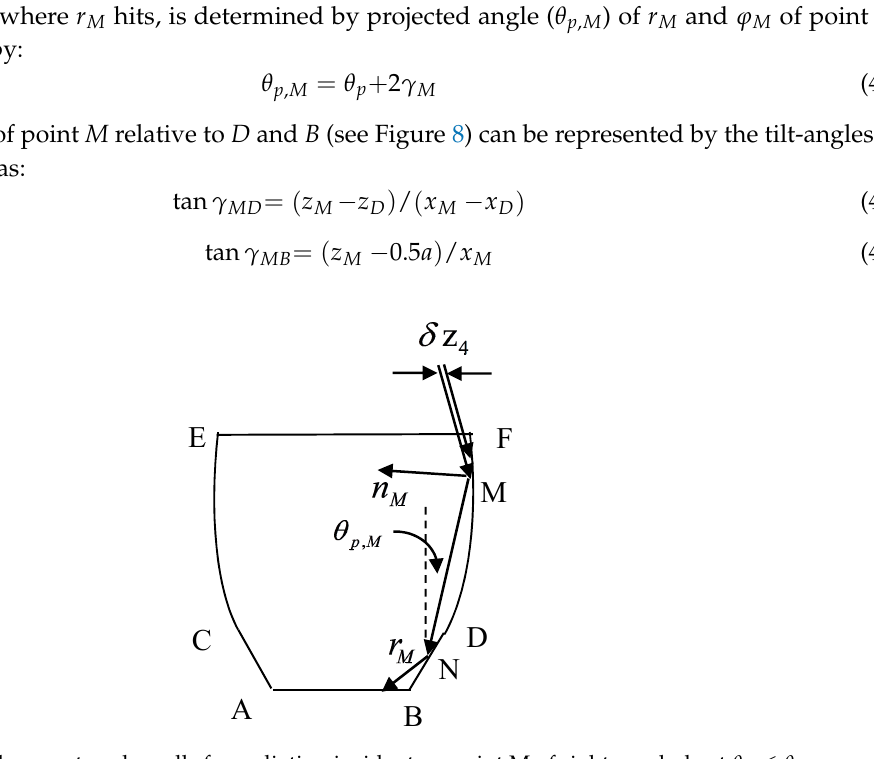
Figure 8. The way to solar cells for radiation incident on point M of right parabola at θ p ≤ θ a . For θ p , M ≥ γ